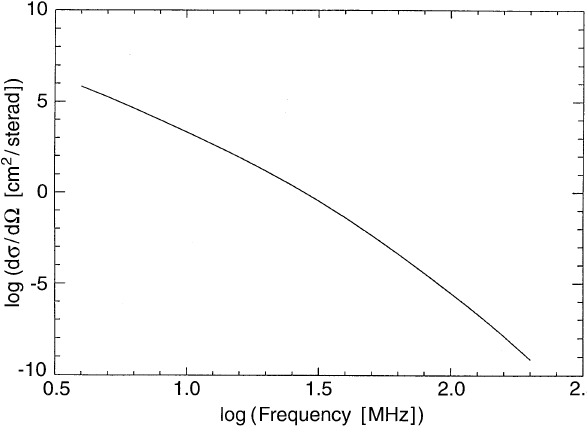
Fig. 3. Cross-section per unit solid angle as a function of radar frequency